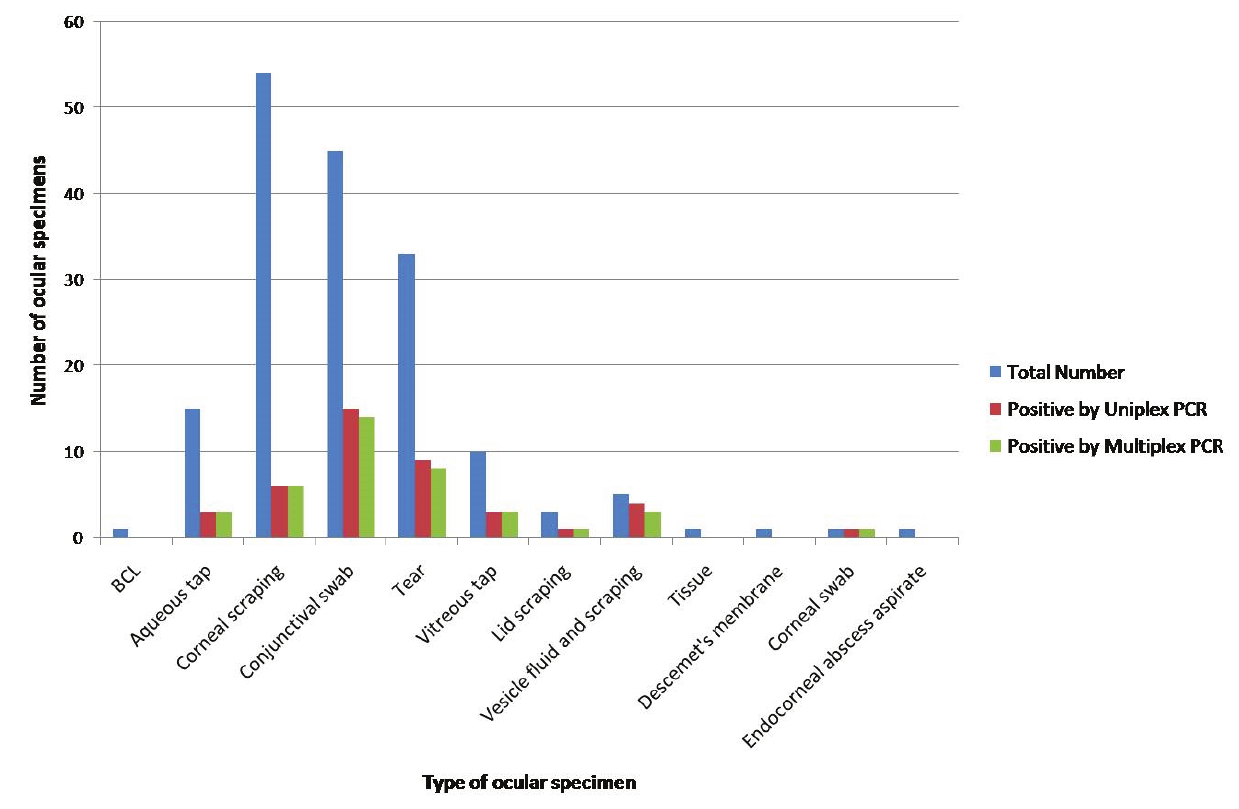
Figure 3. Sample-wise distribution of results of uniplex and multiplex